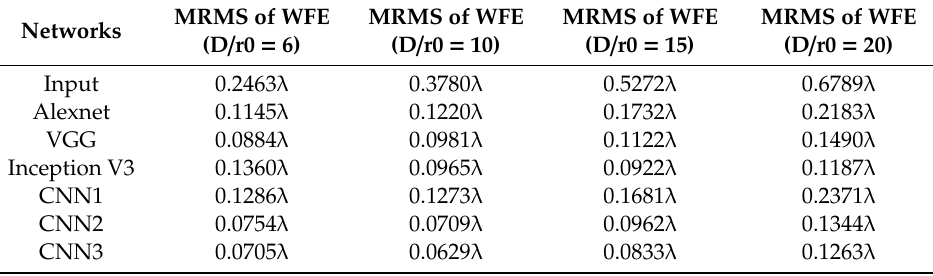
Table 3. The simulation of generalization